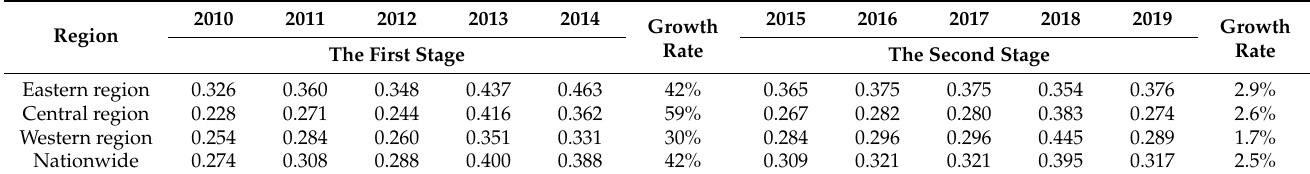
Table 3. Comparison of green development in China from 2010 to 2014 and 2015 to 2019.